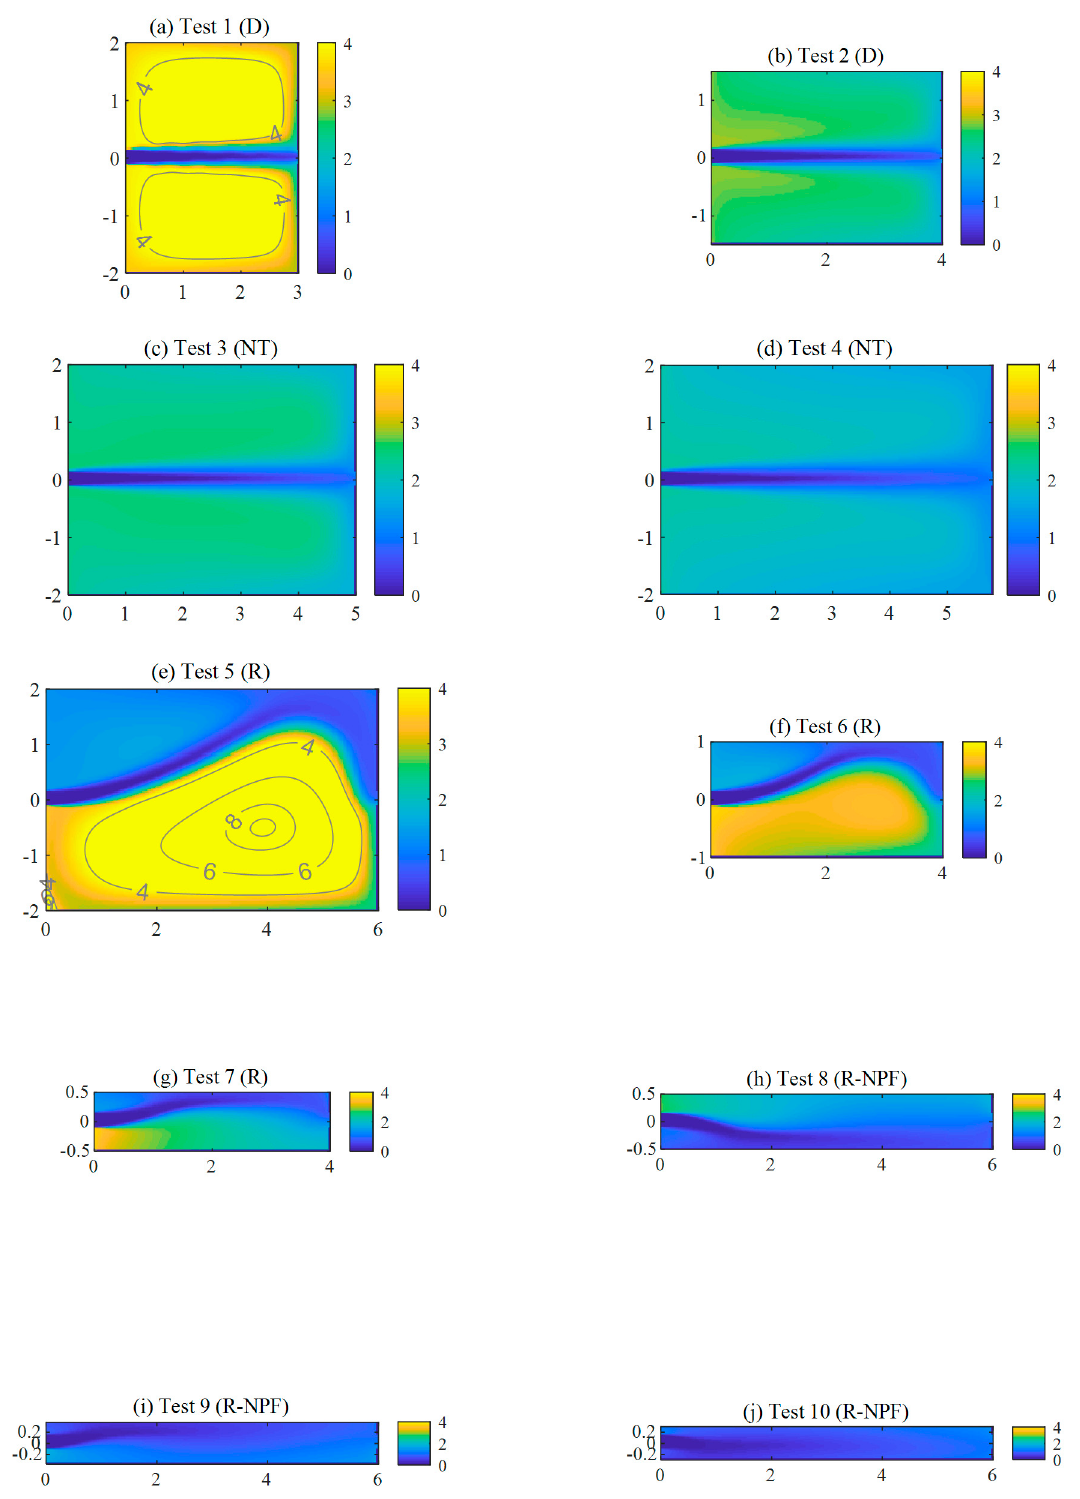
Figure 6. Computed mean age a , scaled by the characteristic time V / Q . Contours are represented only for values of a / ( V / Q ) ≥ 4, i.e., beyond the range of the color scale. Subfigures ( a – j ) correspond to the 10 reservoir configurations.